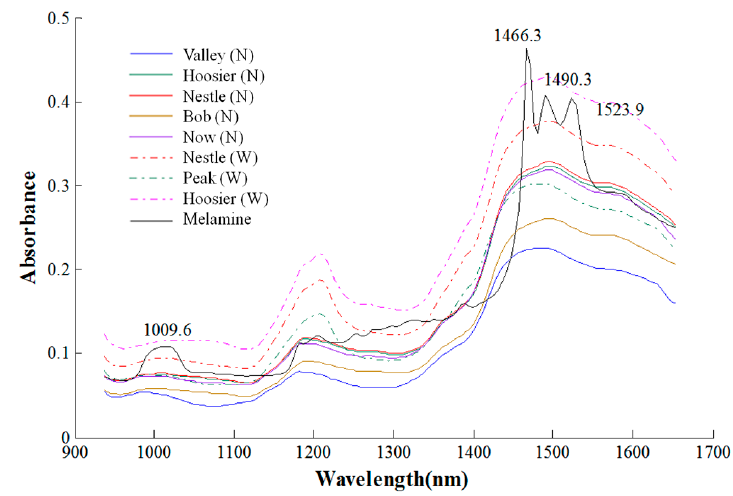
Figure 3. Representative mean spectra of pure nonfat (N) and whole (W) milk powders and pure melamine, each calculated from a 10,000-pixel ROI.